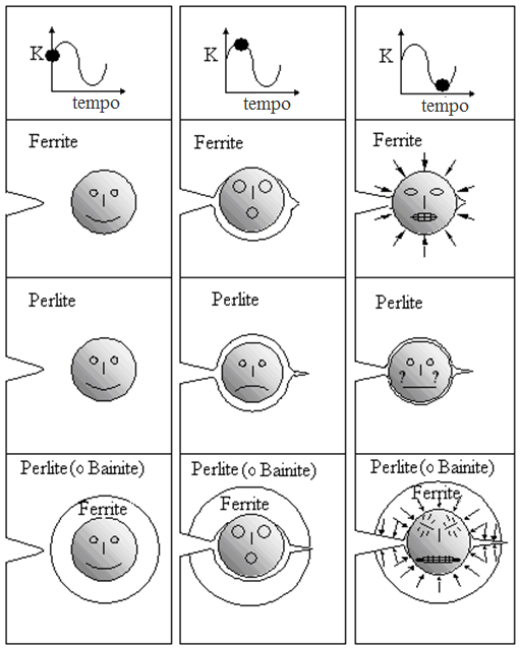
Figure 67: Microstructure influence on graphite nodules – matrix